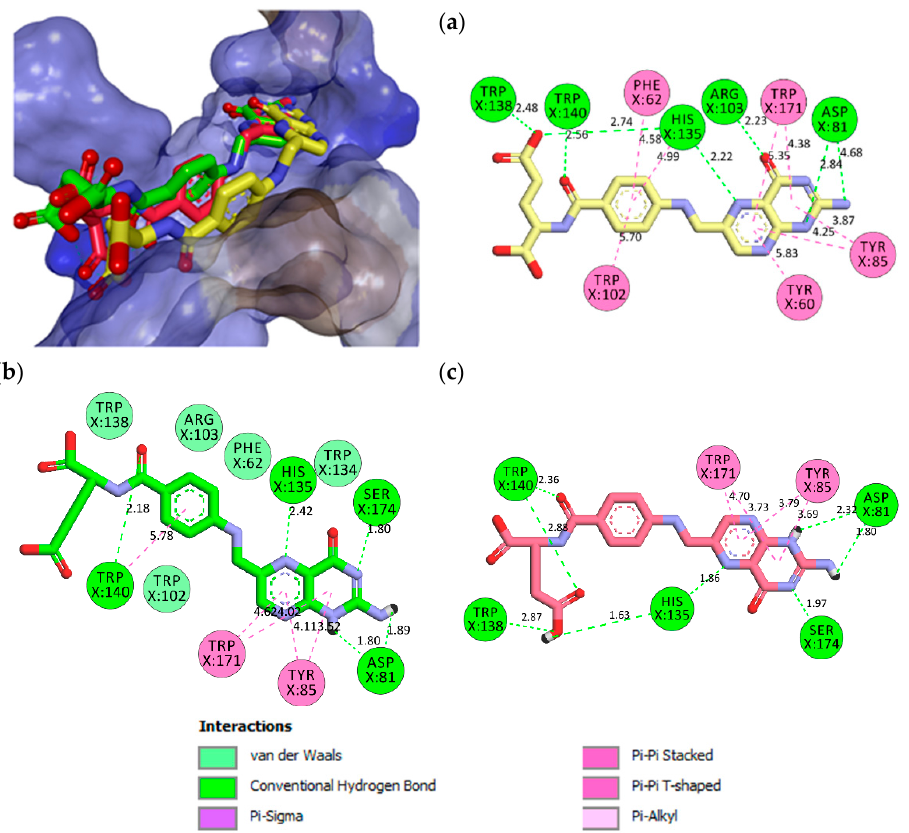
Figure 8. The FA ligand orientation and its interactions with FR α during the molecular dynamics (MD) simulation at 20 ns ( a ), 77.28 ns ( b ), and 94.96 ns ( c ).